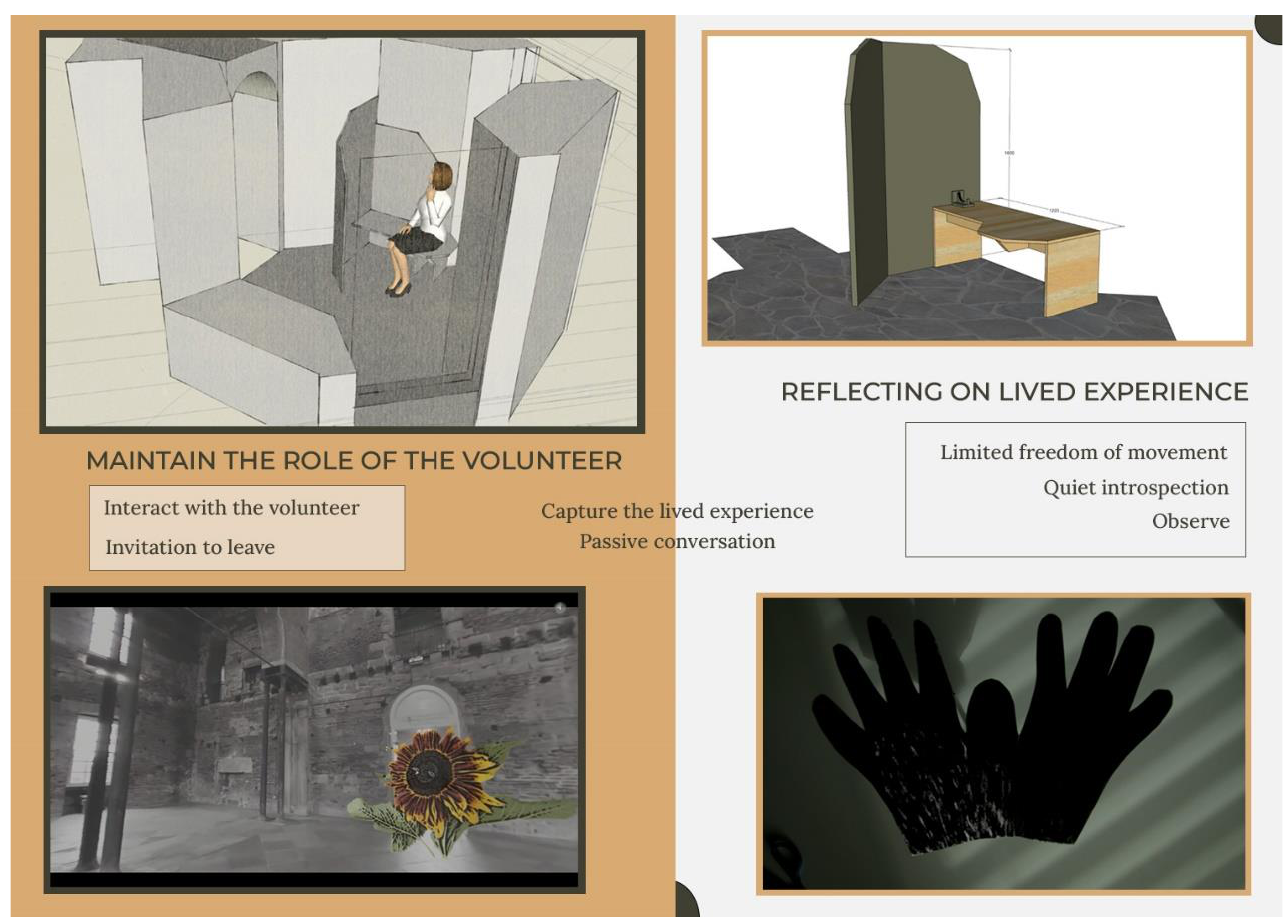
Figure 7. Un/Authorised View Design Domains and Interaction